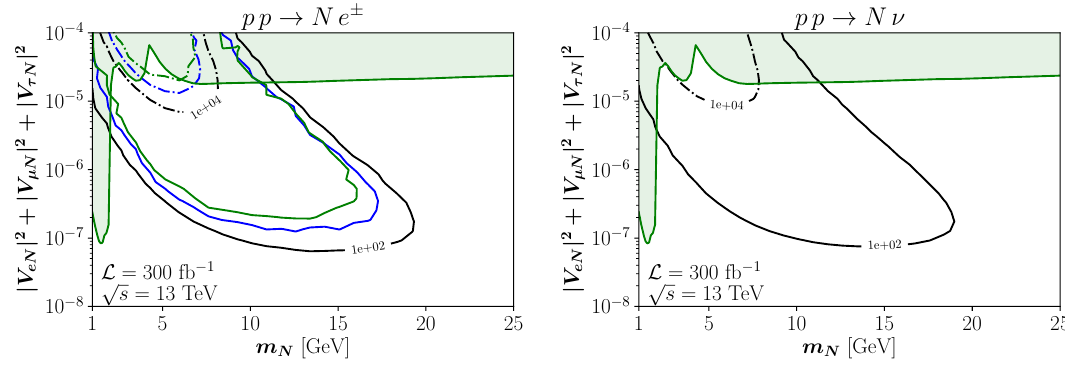
Figure 5 . Left: HNL production in association with a e (cid:6) , for three scenarios: only one mixing V eN (black), two mixings j j Right: HNL production in association with a light active neutrino. Here the three scenarios give the same results. In both panels, solid (dot-dashed) lines are contour lines for 10 2 (10 4 ) events with DV at the LHC 13 TeV with the DV are imposed. Shaded green areas are excluded by experimental